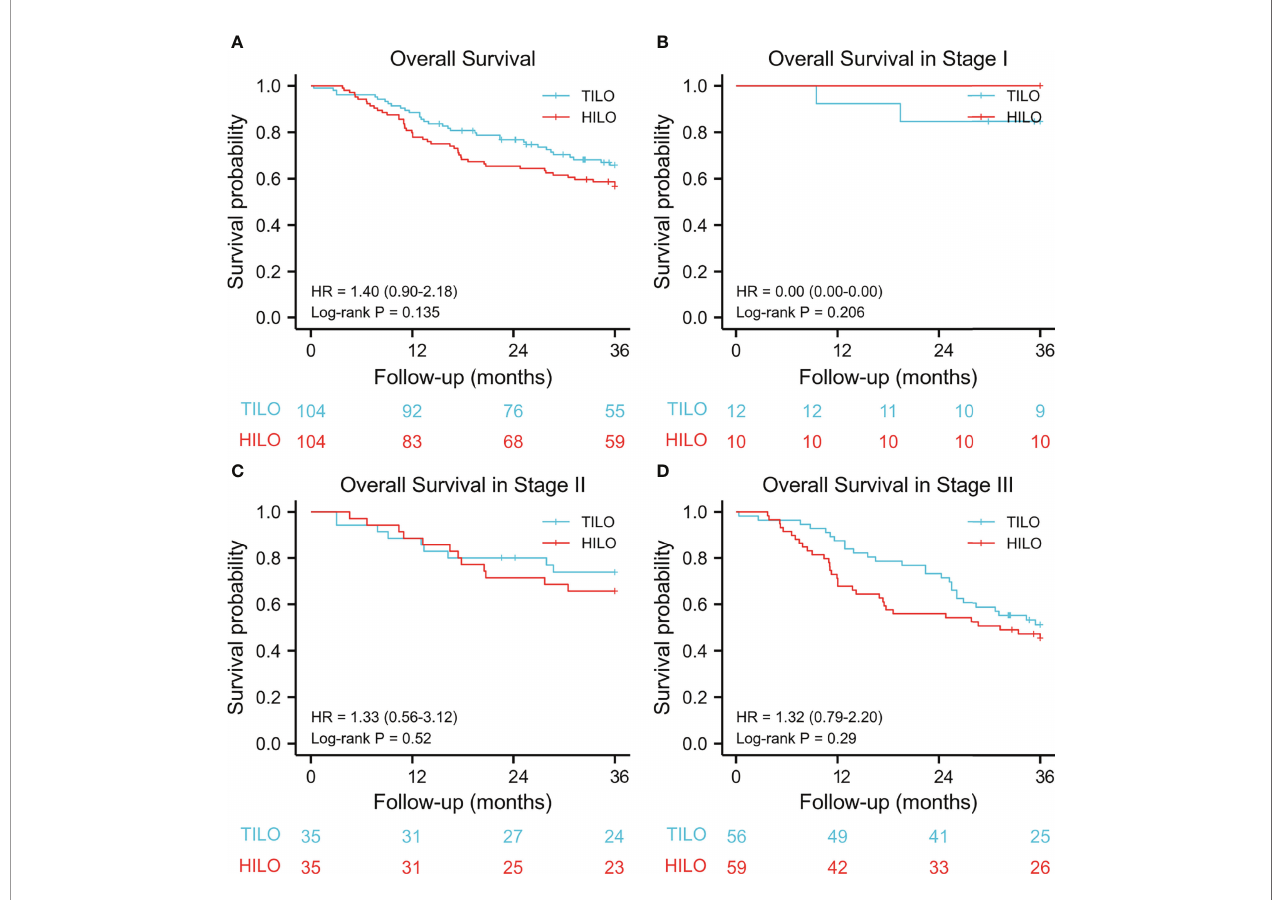
FIGURE 3 | Kaplan – Meier overall survival curves strati fi ed by clinical stage. (A) the entire cohort, (B) stage I; (C) stage II, (D) stage